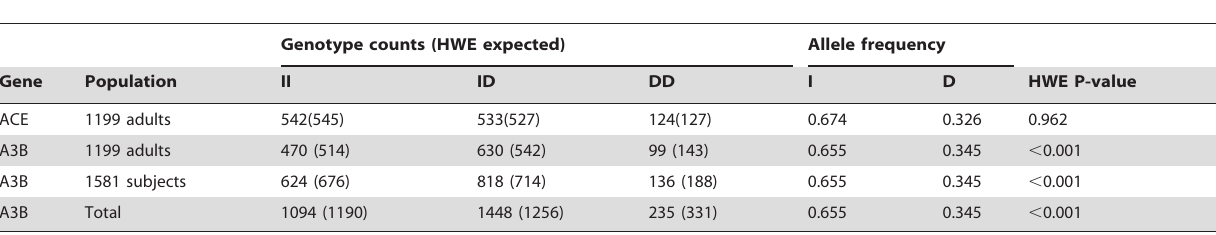
Table 1. A3B and ACE genotype/allele distributions in the study population.